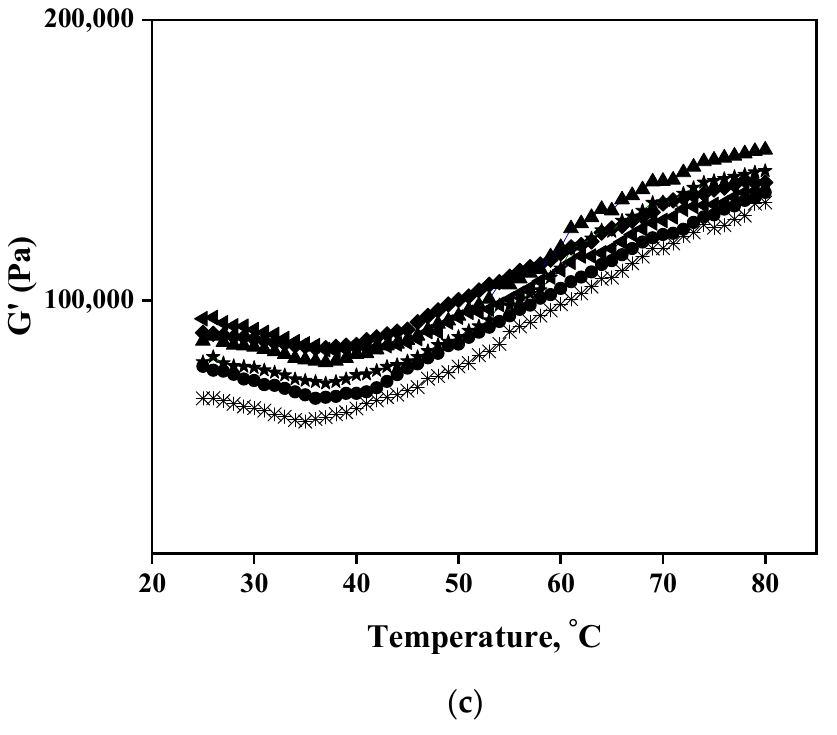
Figure 2. ( a ) Storage (G′, open symbols) and loss (G″, closed symbols) modulus of the meat batters as a function of frequency for Control ( ◀ , ◁ ), PEG5 ( ◆ , ◇ ), PEG10 ( ▲ , △ ), PEG15 ( ★ , ☆ ), PEG20 (●, ○ ), PEG25 ( ■ , □); ( b ) Storage modulus (G′) of meat emulsions during heating; ( c ) and cooling for control ( ◀ ), PEG5 ( ◆ ), PEG10 ( ▲ ), PEG15 ( ★ ), PEG20 (●), PEG25 ( ).